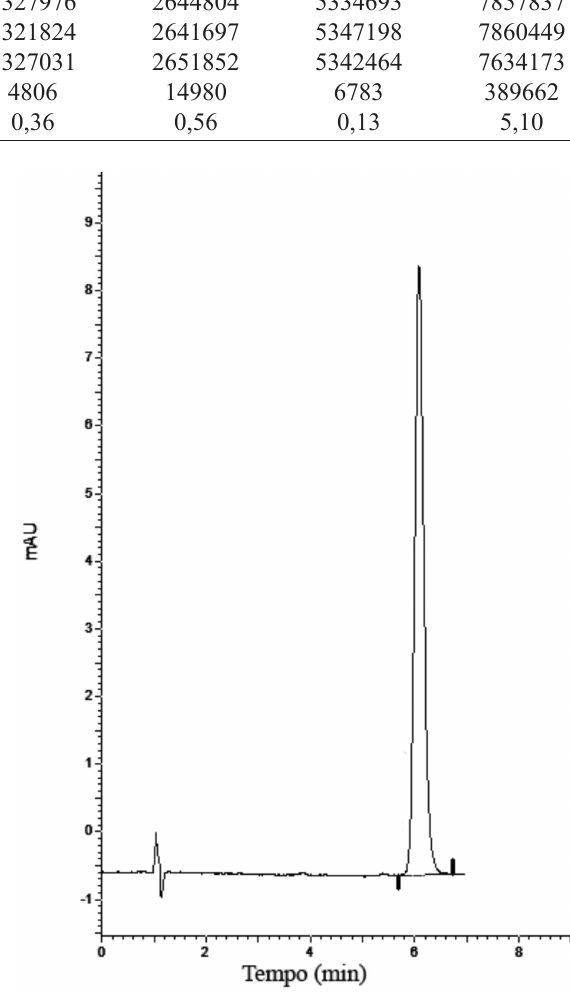
FIGURA 1 - Cromatograma de ácido retinóico obtido por CLAE- UV a 350 nm. As análises foram realizadas em